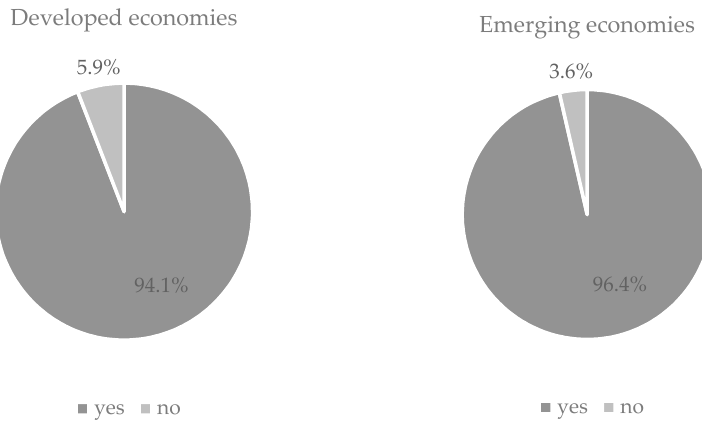
Figure 6. Awareness of benefits that social technology can provide.